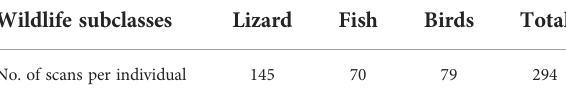
TABLE 1 Dataset of wildlife CT scans used for algorithm development.